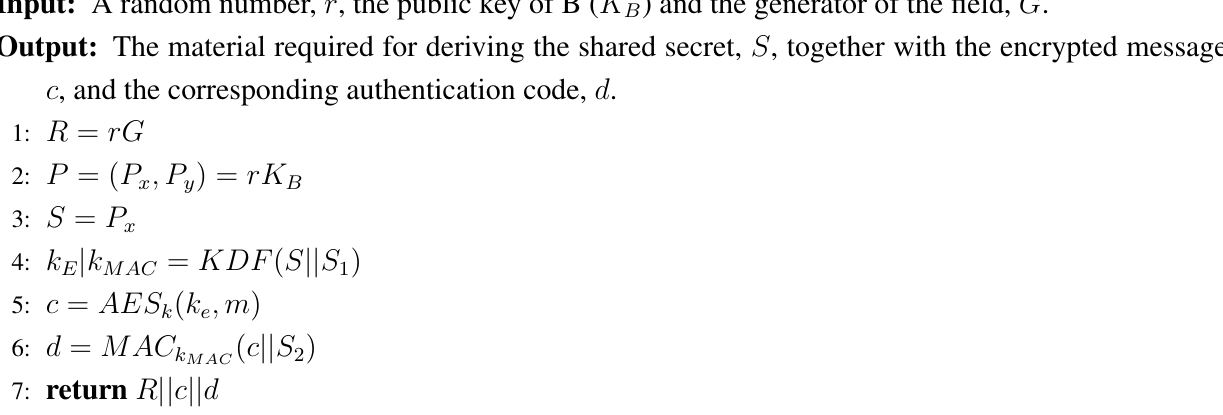
Algorithm 6 Elliptic Curve Integrated Encryption Scheme (ECIES) encryption operation